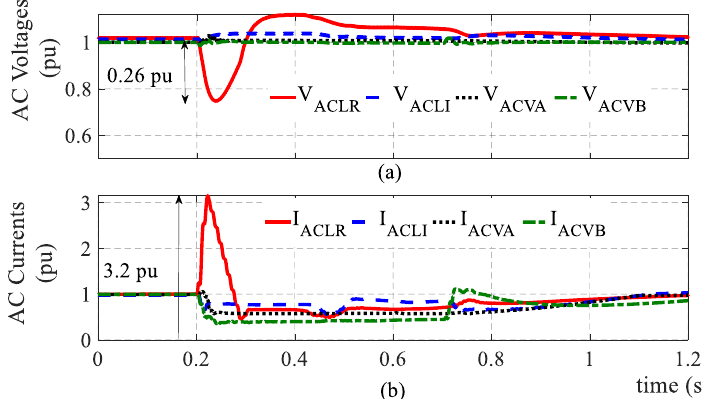
Figure 11. AC side measurements during P-Pole-to-N-Pole fault on the main transmission line ( a ) voltages, ( b ) currents.